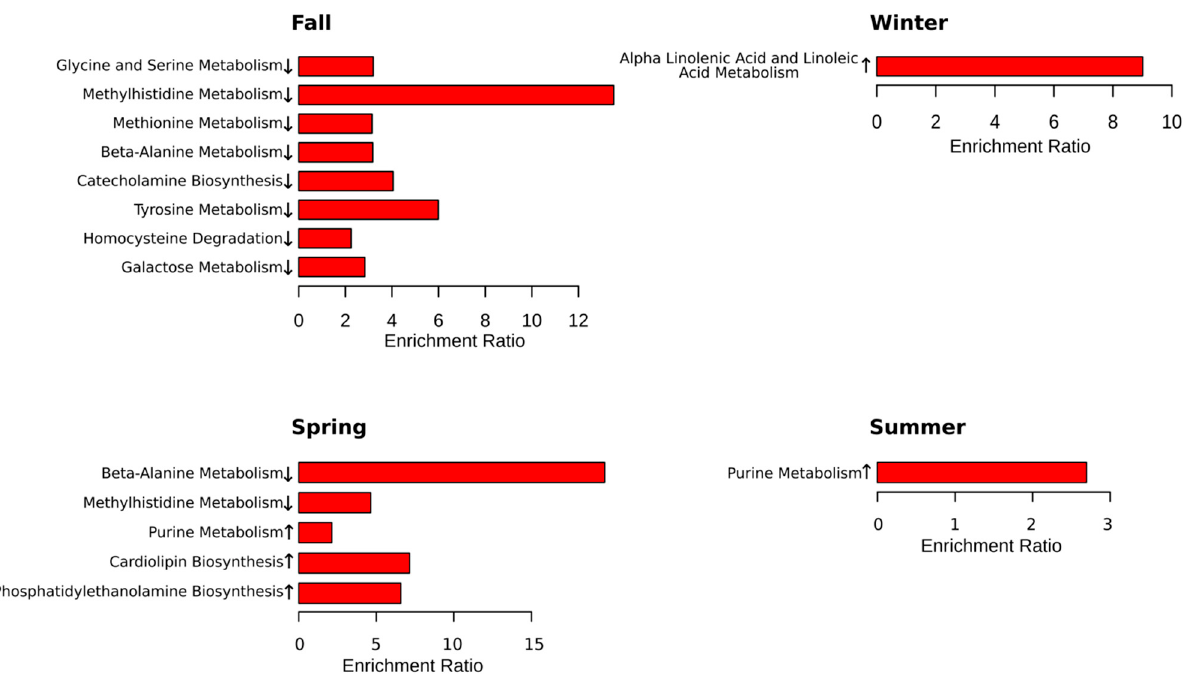
Figure 4. Metabolic pathways significantly enriched in each season. Enrichment analysis was performed in MetaboAnalyst 5.0 (Available online: https://www.metaboanalyst.ca (accessed on 8 November 2022)) using The Small Molecule Pathway Database (SMPDB, Available online: https://smpdb.ca (accessed on January 2014)). Enrichment ratio is computed by hits/expected, where hits = observed hits; expected = expected hits. ↑ —increased serum level of metabolites included in the metabolic pathway in MS compared to control; ↓ —decreased serum level of metabolites included in the metabolic pathway in MS compared to control.